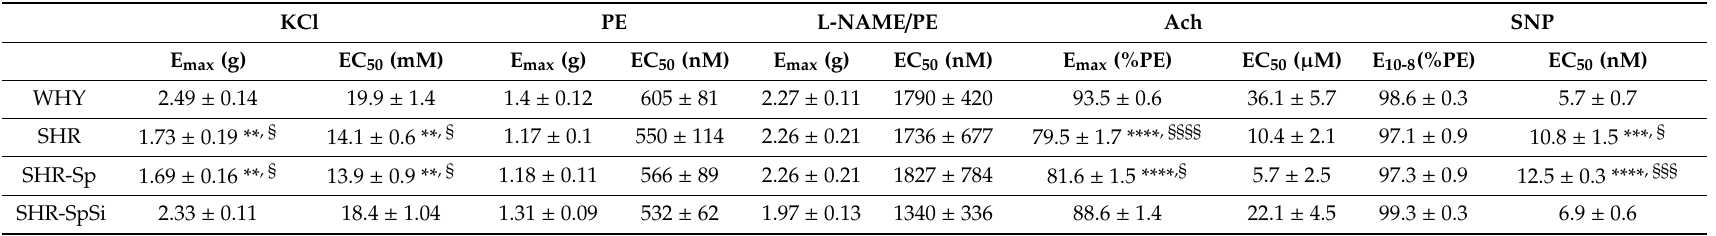
Data are mean ± s.e.m ( n = 15). **** p < 0.0001, *** p < 0.001, ** p < 0.01, * p < 0.05 vs. WKY; §§§§ p < 0.0001, § p < 0.05 vs.